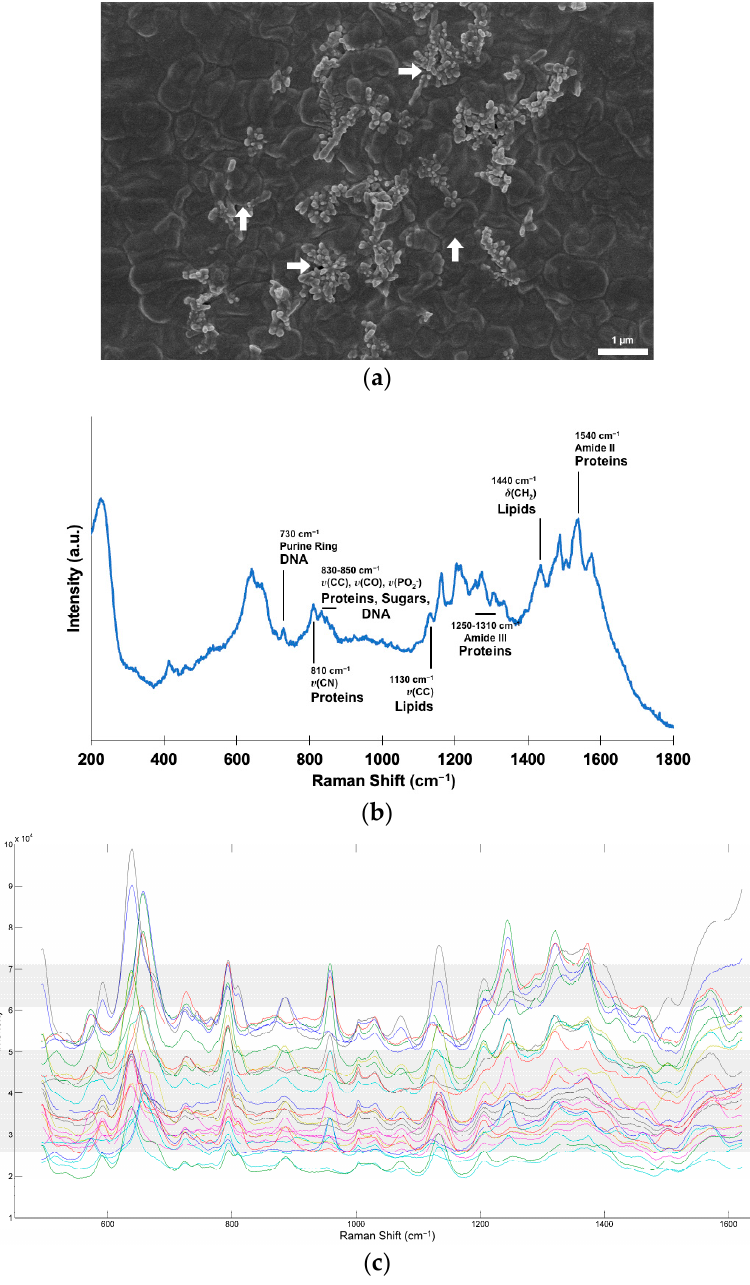
Figure 2. ( a ) SEM micrograph of A. baumannii incubated with AgNSs (10,000× magnification). AgNSs are indicated by horizontal arrows, and bacterial cells are indicated by vertical arrows; ( b ) corresponding SERS spectrum with tentative attributions of biomolecules to some of the vibrational lines; ( c ) SERS spectra of multiple A. baumannii isolates.